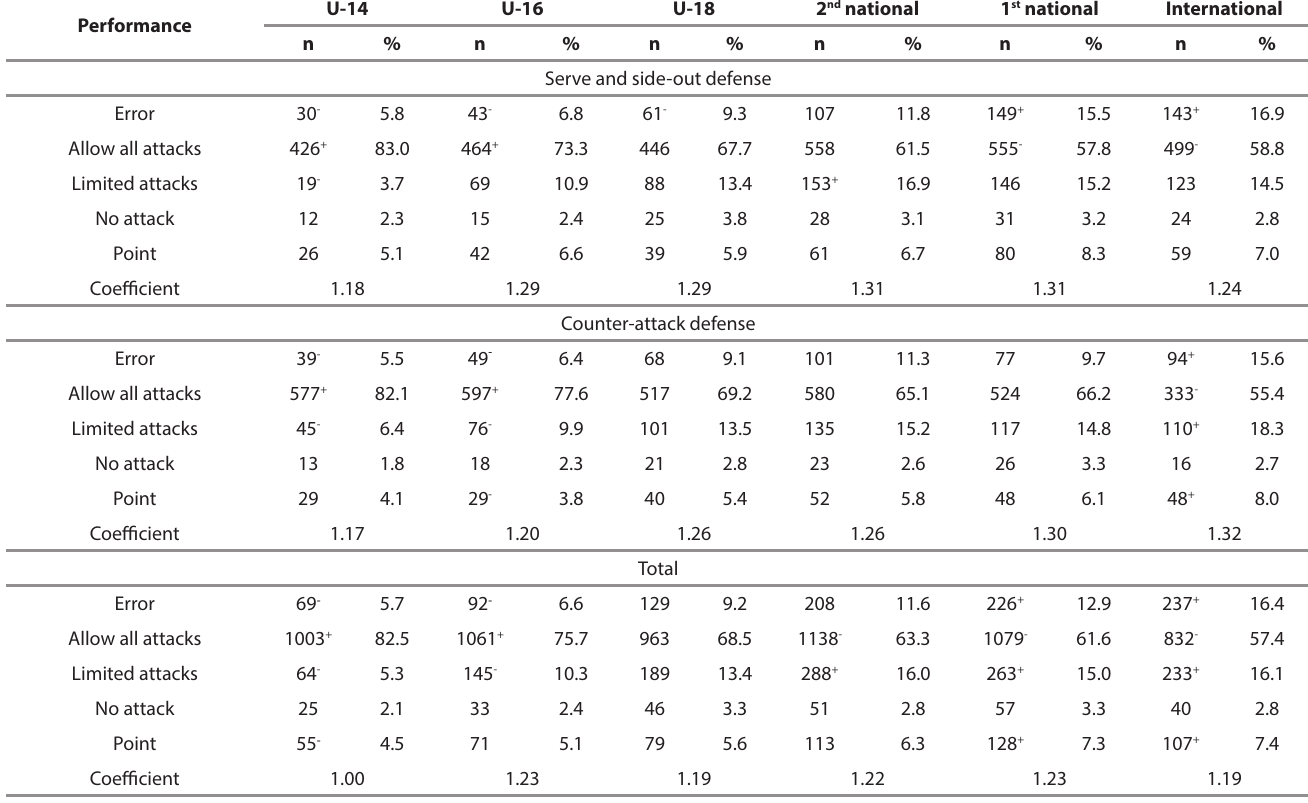
TABLE 2. Performance of the block according to game phase and levels of competition (women’s